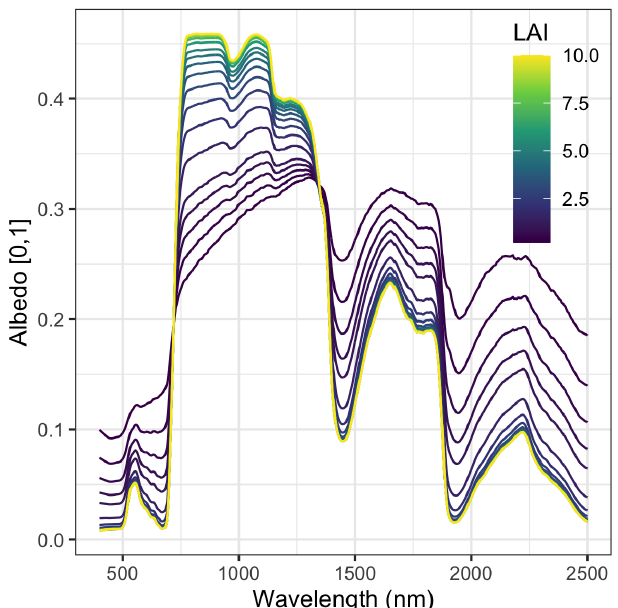
Figure A1. Sensitivity of EDR-predicted hemispherical reflectance to true LAI. These simulations assume a single-cohort canopy with effective number of mesophyll layers N = 1 . 4, total chlorophyll content Cab = 40, total carotenoid content Car = 10, leaf water content Cw = 0 . 01, leaf dry matter content Cm = 0 . 01, clumping factor q = 1, leaf orientation factor χ = 0, cos (θ s ) = 0 . 85, and soil moisture fraction ψ = 0 . 5.